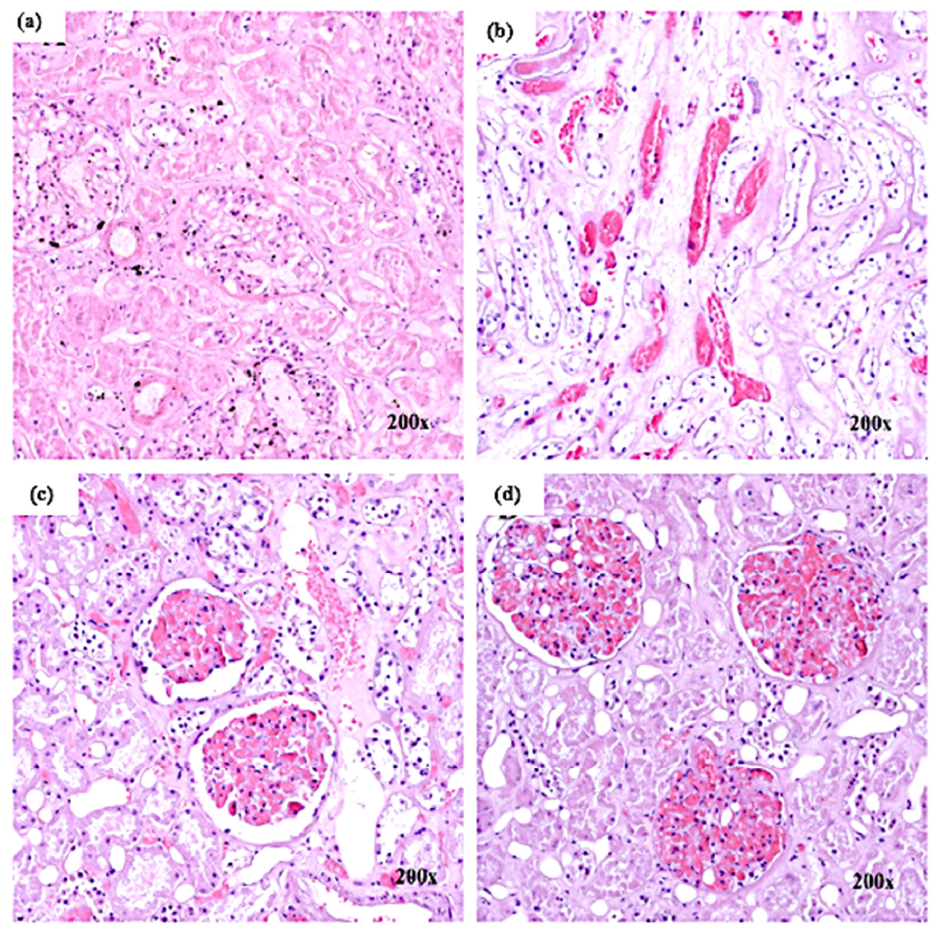
Figure 3. Histological findings in the kidney: ( a ) glomerulus hypercellularity; ( b ) deposition of eosin-positive material in the tubules; ( c ) increased space between Bowman’s capsule and glomerulus; ( d ) increased cellularity in the glomerulus.